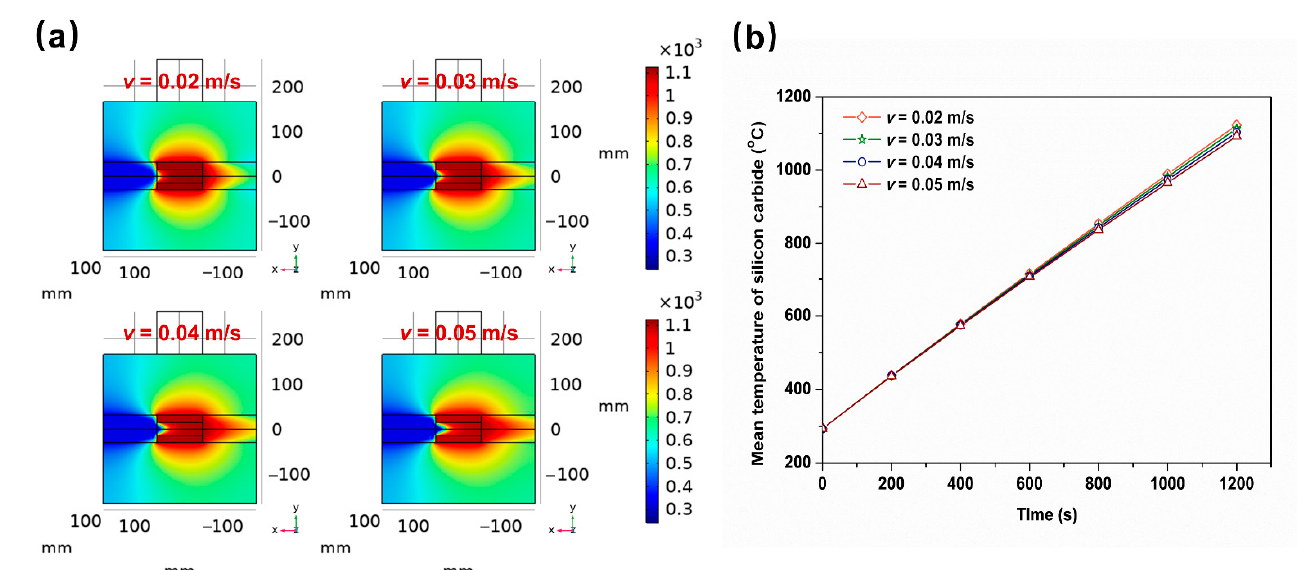
Figure 9. Effect of flow velocity on the simulated thermal fields (the temperature unit: K; x – y plane, z = 0; z i = 5 mm; P = 1000 W; l SiC = 100 mm): ( a ) variation of the thermal fields with different flow velocities; and ( b ) the heating rate of silicon carbide under microwave irradiation with different flow velocities.